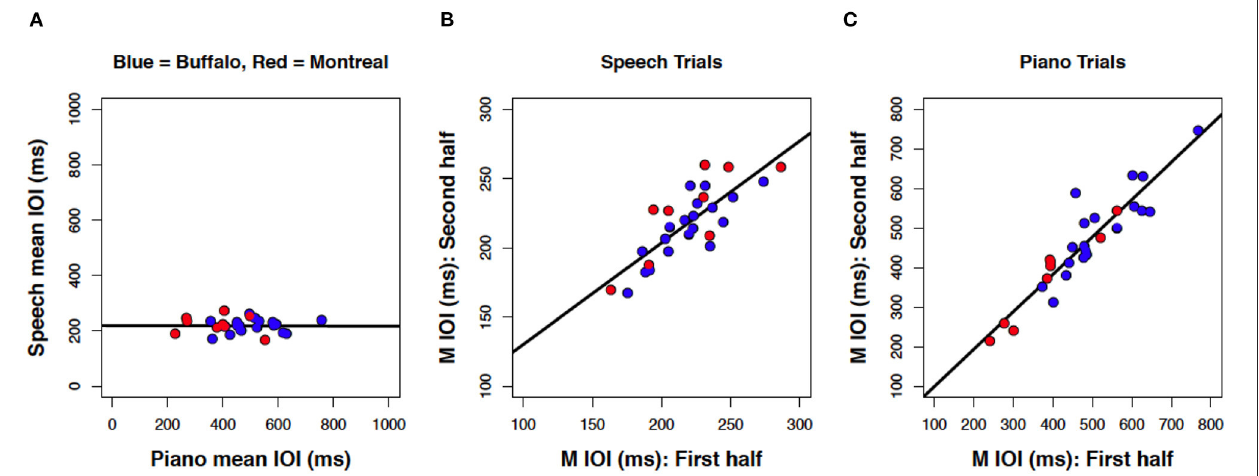
FIGURE 8 | Scatterplots of mean IOI between speech and music (A) ; within speech (B) and within piano (C) , including data from both Experiment 1 (blue) and Experiment 2 (red). Each dot represents one participant ( N = 28 each